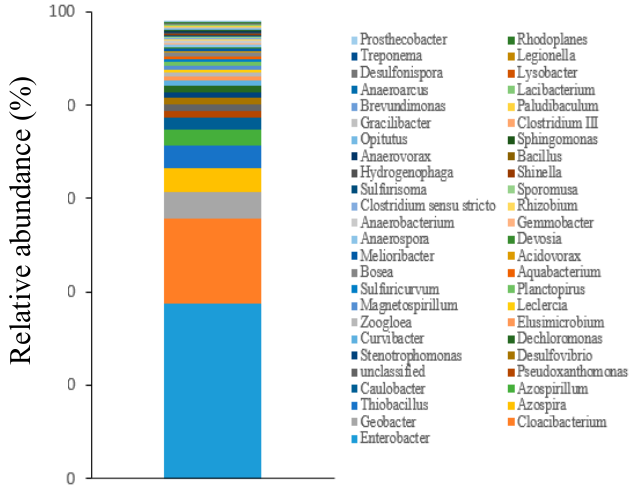
Figure 8. Population abundance map at the genus level of microorganisms.